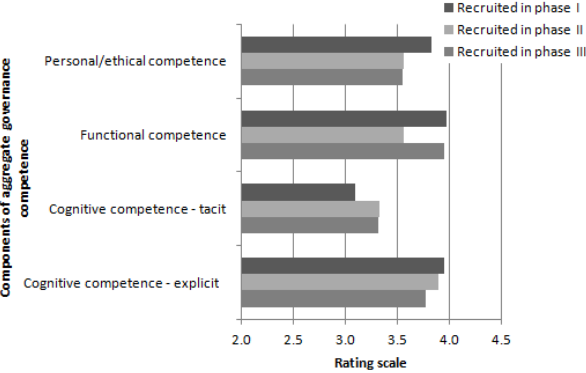
Fig. 10. Components of the aggregate governance competence per- ceived to be acquired from local post-graduate education and inter- national post-graduate education, in phase I (1970–1987), II (1987– 1998) and III (1998–present); rating scale from 1 to 5, where 1=not at all, 3=to some extent, and